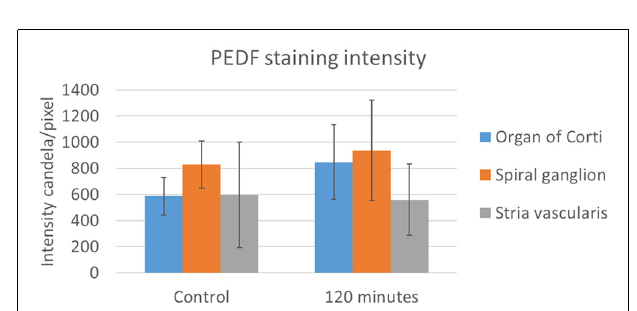
FIGURE 6 | PEDF in the stria vascularis following furosemide injection. Densitometry of PEDFstaining intensity. Result presented as mean values of the control and 120 min group, with error bars showing standard deviation. The organ of Corti (blue) showed a large increase and in the spiral ganglion (orange) a marginal increase, while the stria vascularis (gray) had no change.